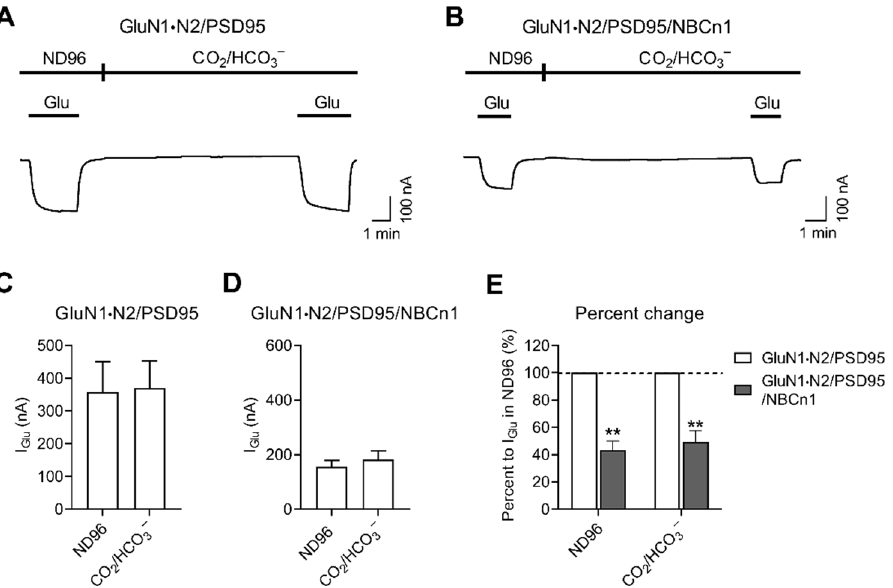
Figure 5. The I Glu decrease by NBCn1 channel activity is independent of CO 2 /HCO 3 − . ( A , B ) Repre- sentative I Glu produced by GluN1·N2/PSD95 ( A ) and GluN1·N2/PSD95/NBCn1 ( B ). I Glu was meas- ured in ND96 solution and 10 min after applying a solution equilibrated with 10% CO 2 , 50 mM HCO 3 − at constant pH 7.4. Except when glutamate was applied, Na + -free CO 2 /HCO 3 − solution was applied to minimize pH i change by cotransport activity. ( C ) Mean I Glu produced by GluN1·N2/PSD95 ( n = 4; ( C )) and GluN1·N2/PSD95/NBCn1 ( n = 6; ( D )). ( E ) Effects of NBCn1 on I Glu in the absence and presence of CO 2 /HCO 3 − . Data were presented as percent change relative to I Glu by GluN1·N2/PSD95. ** p <